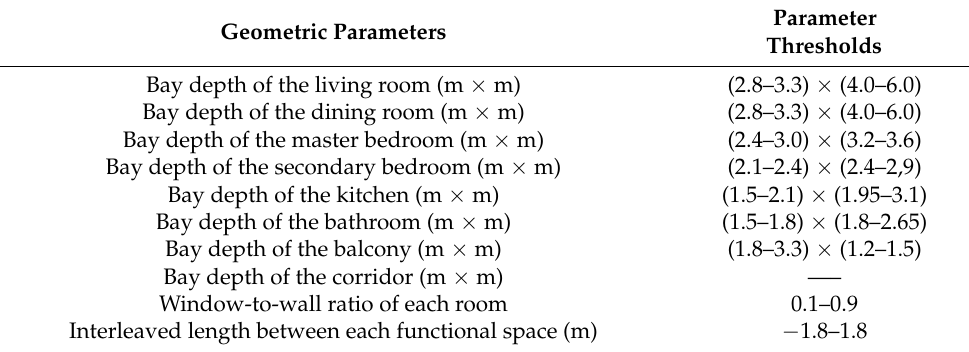
Table 1. Building geometric parameter threshold. Geometric